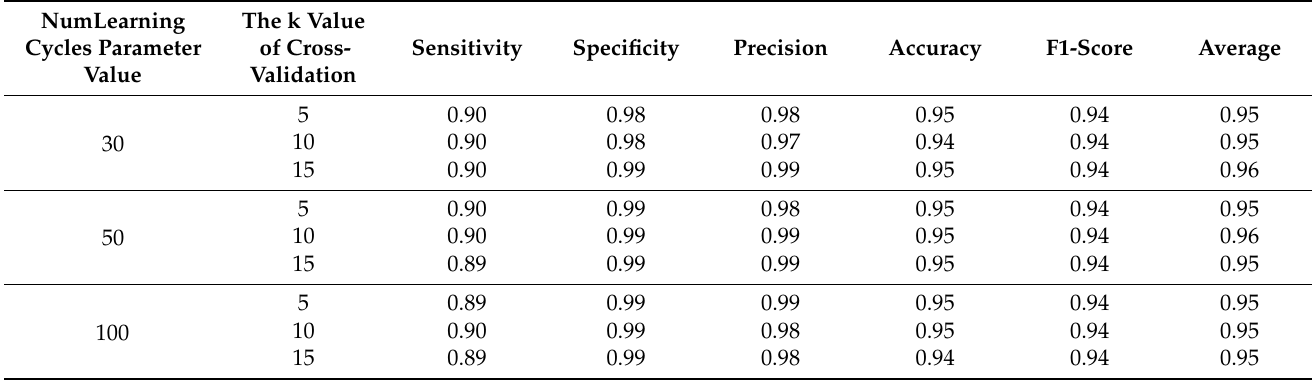
Table 3. Results of calculating measures of diagnostic test value for packed decision